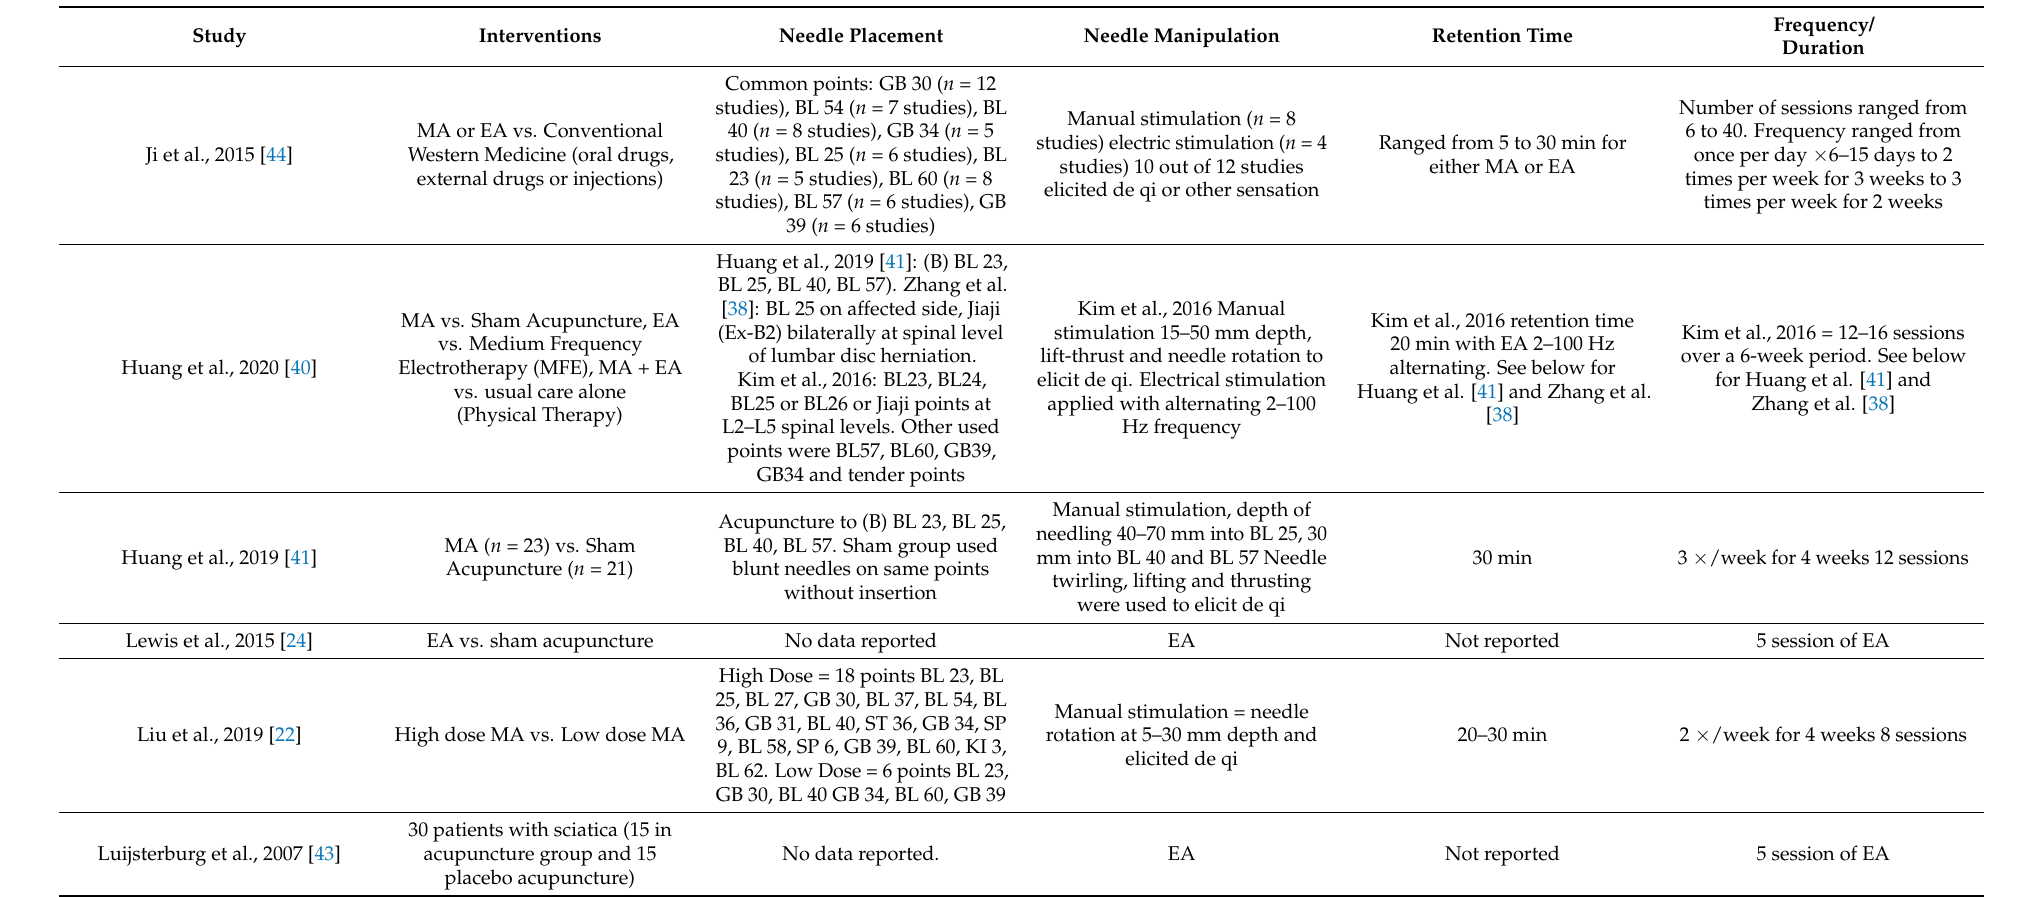
Table 4. Description of needling